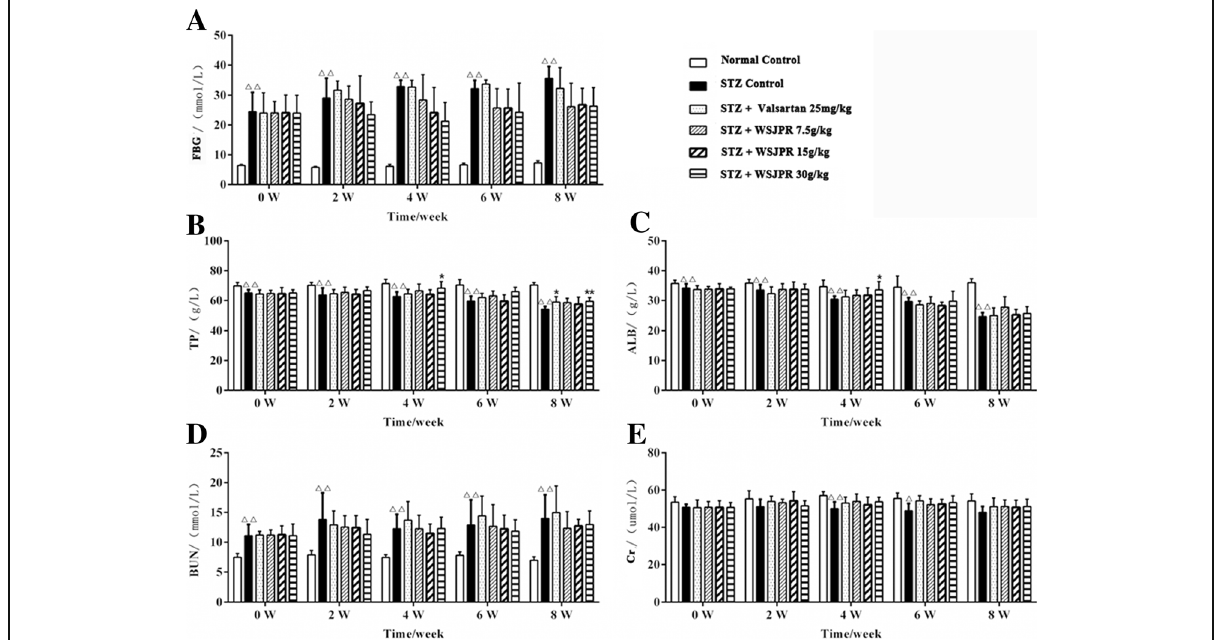
Fig. 2 Effect of WSJPR on FBG ( a ), serum TP ( b ), ALB ( c ), BUN ( d ), and Cr ( e ) in rats at different times ( n = 8). △ P < 0.05, △△ P < 0.01 vs. normal control and * P < 0.05, ** P < 0.01 vs. STZ control; mean ± (Fig. 2e). The FBG, BUN and Cr levels in the WSJPR and